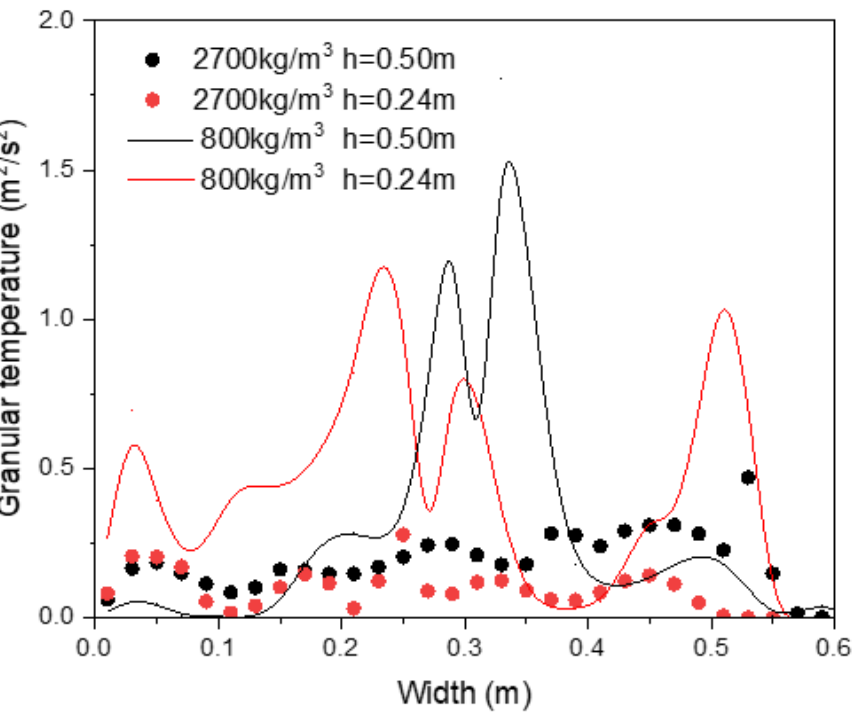
Figure 16. Comparisons of the averaged granular temperature of particles with density of ρ p = 2700 kg/m 3 and ρ p = 800 kg/m 3 at the height of 0.24 m and 0.5 m.